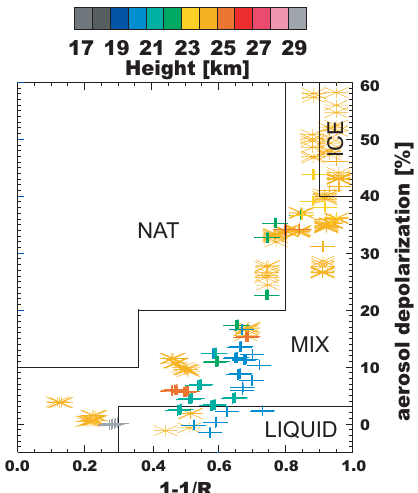
Fig. 2. PSC classification scheme for the inhomogeneous PSC ob- served on 2 January 2008 (see Fig. 1). The boundaries for NAT, Ice, mixed-particle, and STS PSCs are drawn into the plot as lines. The different colors and symbols represent the height of the